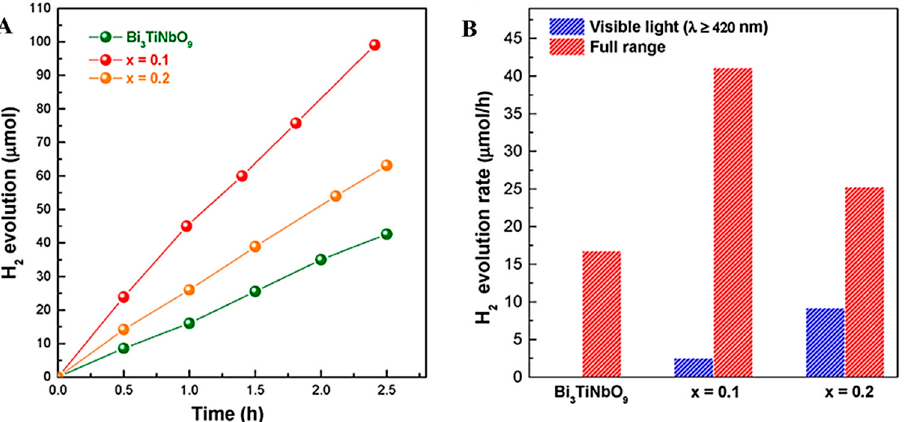
Figure 10. ( A ) Photocatalytic hydrogen production of all samples under full range illumination ( λ ≥ 250 nm) in sodium sulfite aqueous solution (0.05 M). ( B ) Average photocatalytic hydrogen production rate under full range ( λ ≥ 250 nm) and visible light illumination ( λ ≥ 420 nm) [340].